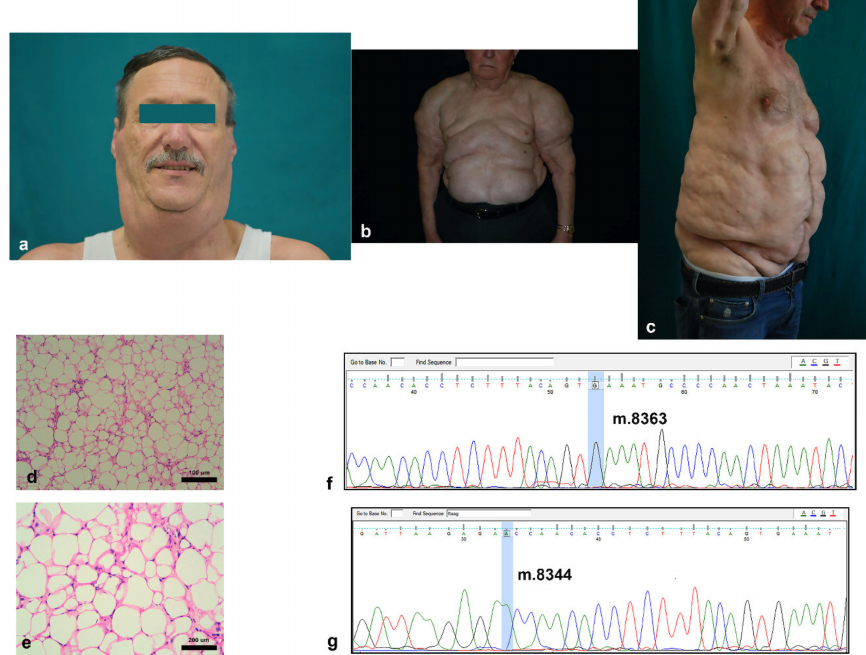
Figure 1. Clinical and histological features of MD: ( a – c ) representative pictures of typical anatomical localization of excessive adipose tissue in the cervical ( a ), upper trunk (the pseudoathletic appearance) ( b ), and abdominal ( c ) areas of 3 patients with MD; ( d – g ) representative pictures of hematoxylin and eosin stained adipose tissue sections of an MD patient (( d , e ) at 20 × and 40 × magnification, respectively); and ( f , g ) representative Sanger pherograms of an MD-derived mitochondrial DNA lacking the presence of both m.8363G > A ( f ) and m.8344A > G ( g ) mutations (the interested DNA base positions are highlighted in light blue).